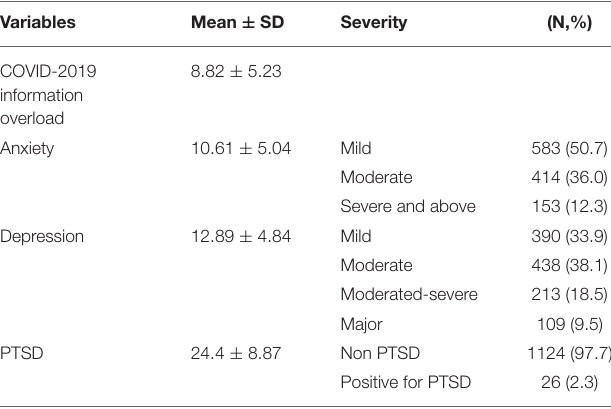
TABLE 2 | Individual’s COVID-2019 information overload, anxiety, depression, PTSD